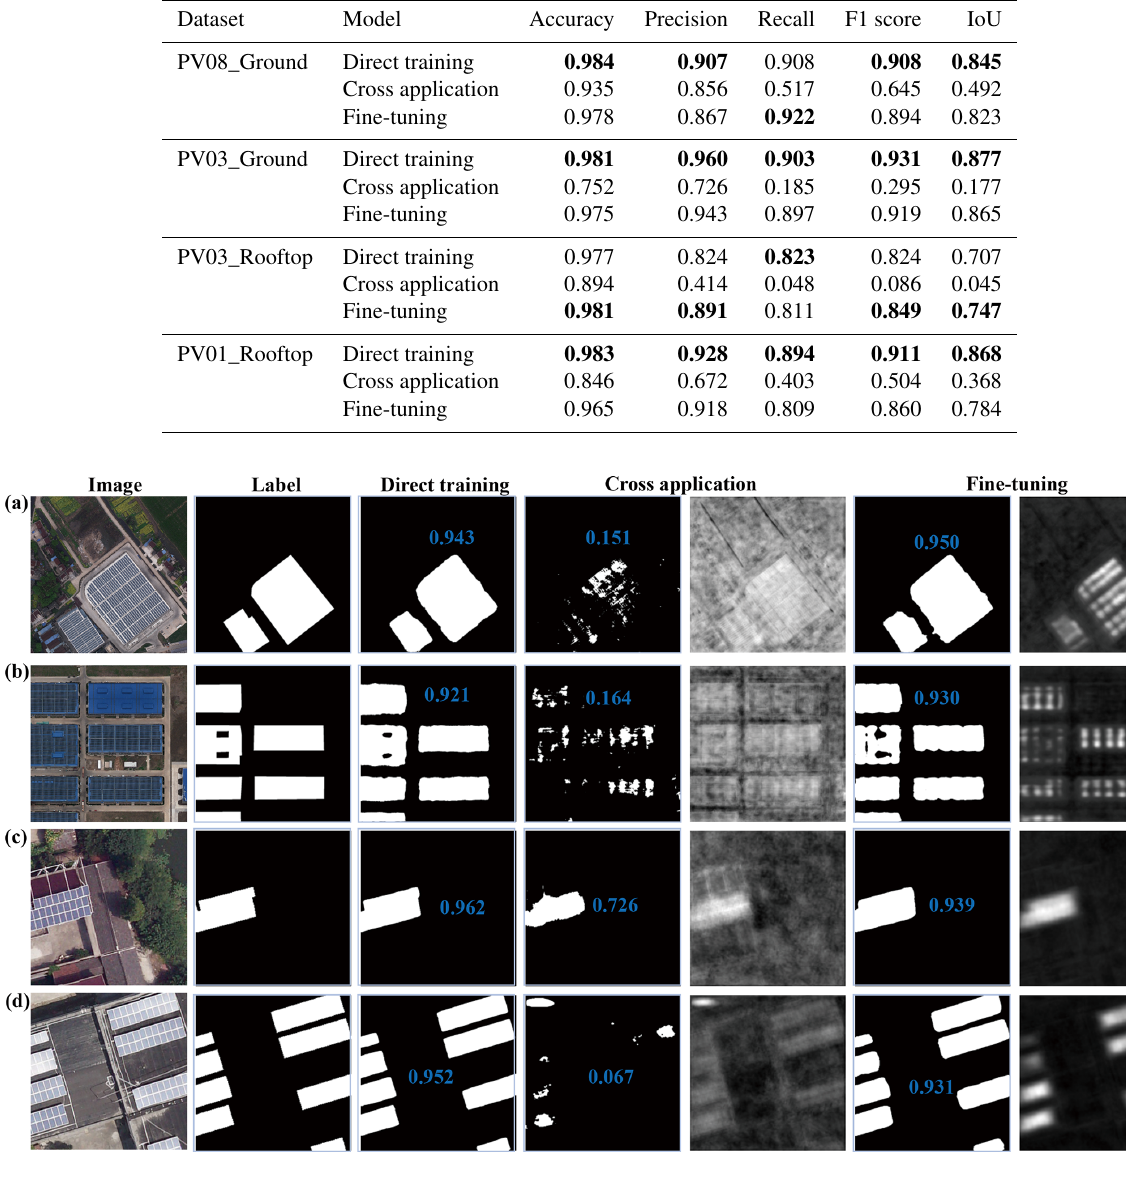
Figure 8. Cross application of rooftop PV samples. Segmentation results of DeepLab v3 + from direct training, cross application, and fine- tuning are shown for PVs in the PV03 (a, b) and PV01 (c, d) datasets. Feature map for cross application and fine-tuning is displayed on the right of the corresponding segmentation result. IoU of each segmentation result is marked in blue within the